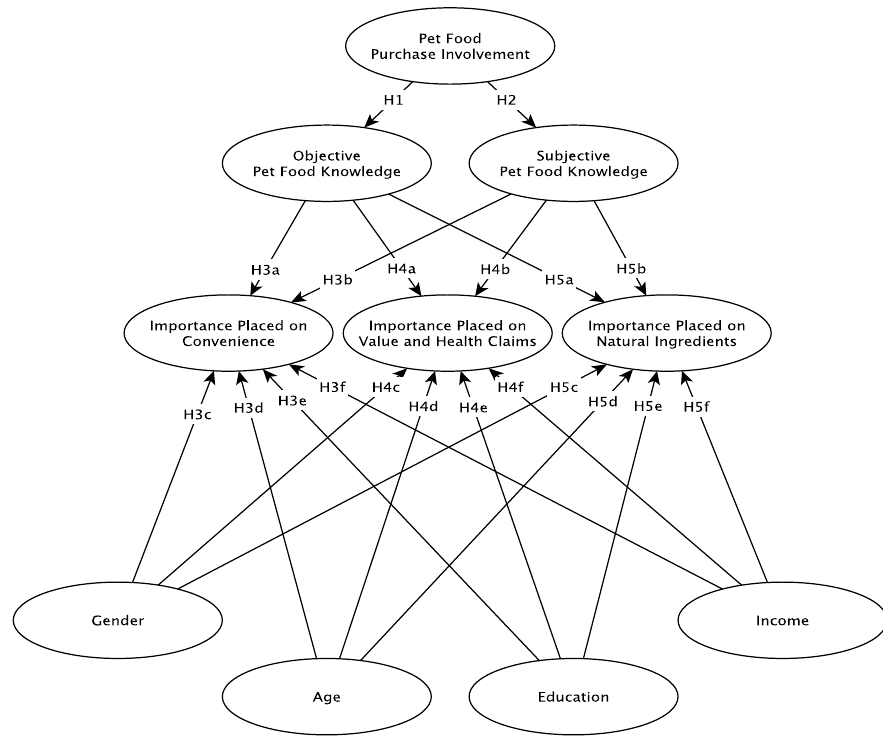
Figure 1. Conceptual Framework.